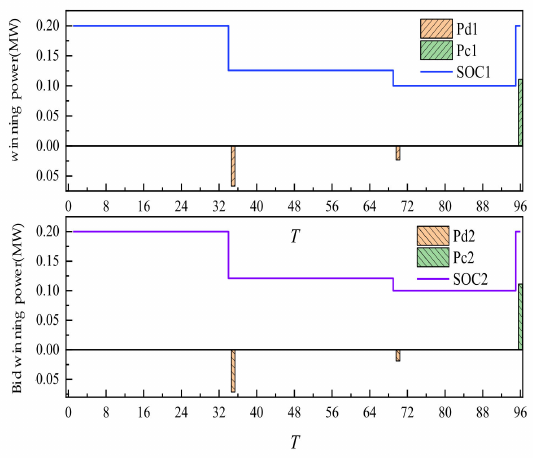
Figure 7. Day-ahead trading of ES.